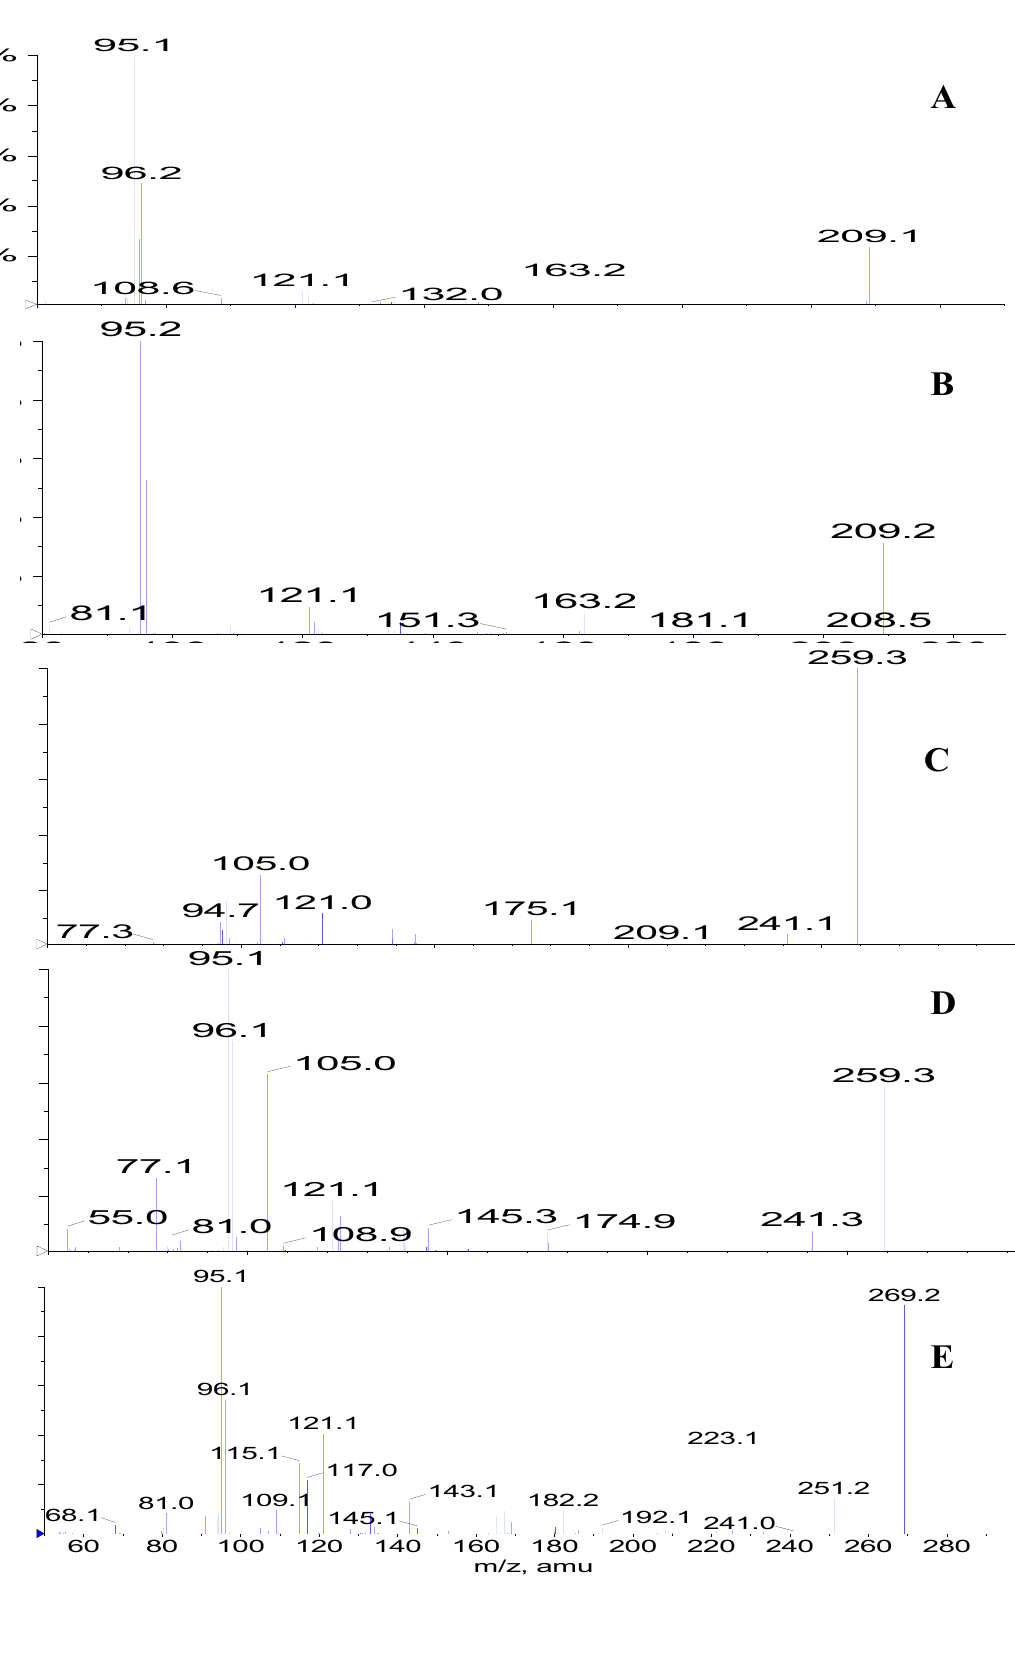
Figure 2. ESI-MS/MS of selected ions from the chromatograms presented in Figure 1: A) m/z 209, peak 3 , isopilocarpine; B) m/z 209, peak 4 , pilocarpine; C) m/z 259, peak 11a , D) m/z 259, peak 11b ; E) m/z 269, peak 12 , anhydropilosine; F) m/z 287, peak 5 , pilosine, G) m/z 287, peak 6 , H) m/z 287, peak 7 ; I) m/z 287, peak 8 and J) m/z 287,